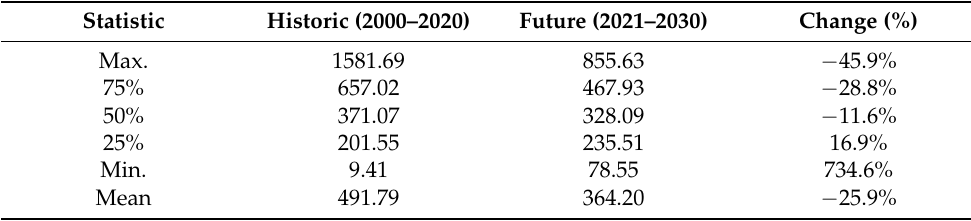
Table 2. The statistics of the monthly SHP potential in the historic and future